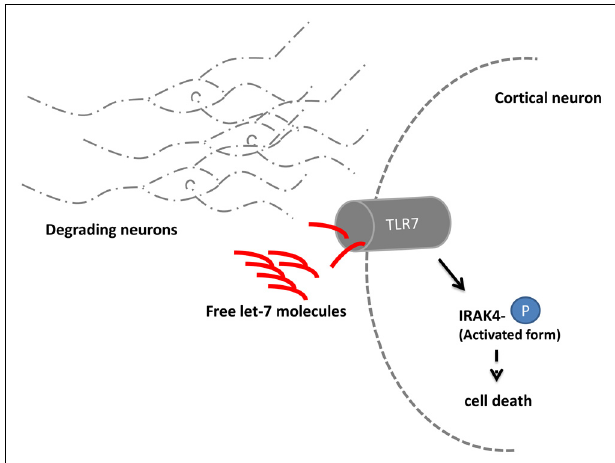
FIGURE 2 | let-7 regulates neuronal degeneration. Neurons degrading due to e.g., the consequences of Alzheimer’s disease release the microRNA let-7 . Extracellular elevated let-7 molecules are sensed by the Toll-like receptor 7 (TLR 7) which is expressed in cortical neurons. Upon binding the downstream molecule IRAK 4 becomes phosphorylated and induces through yet unidentified signaling molecules cell